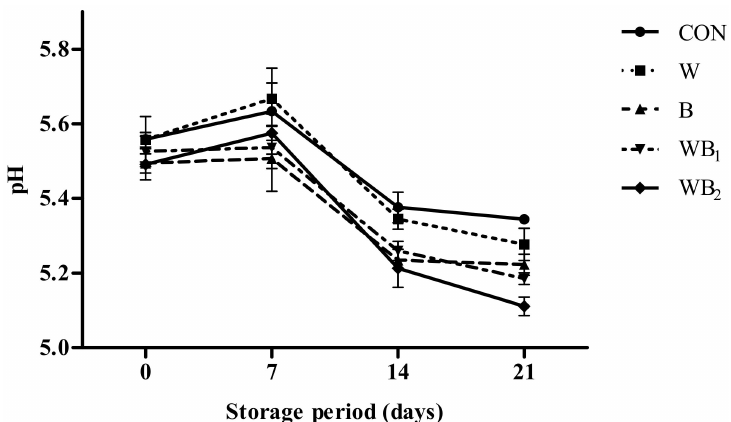
Figure 1. Changes in the pH values of pork patties with di ff erent treatments during refrigerated storage at 4 ◦ C for 21 d. Error bars indicate standard deviations. CON ( • ), control (no additive(s)); W ( (cid:4) ), addition of 2% whey powder; B ( (cid:78) ), addition of 0.5% B. serrata powder; WB 1 ( (cid:72) ), addition of 2% whey powder and 0.5% B. serrata powder; WB 2 ( (cid:7) ), addition of 2% whey powder and 1% B. serrata